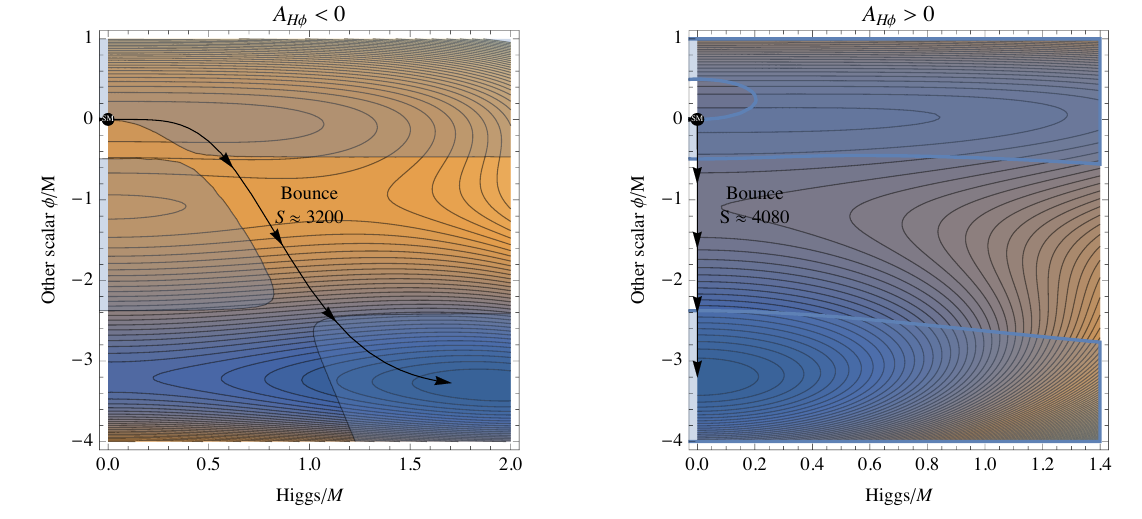
Figure 4 . Numerical examples for the two characteristic classes of landscape potentials of eq. (3.5) that lead to a light Higgs-like scalar and another heavy scalar S . The SM false vacuum lies at the origin. Shaded regions have det V ij > 0. In the left (right) panel the true vacuum has h (cid:24) M ( h (cid:28) M ). The curve with arrow indicates the bounce trajectory; the numerical values of the bounce action show that Higgs-like scalars can be light without leading to catastrophically fast vacuum